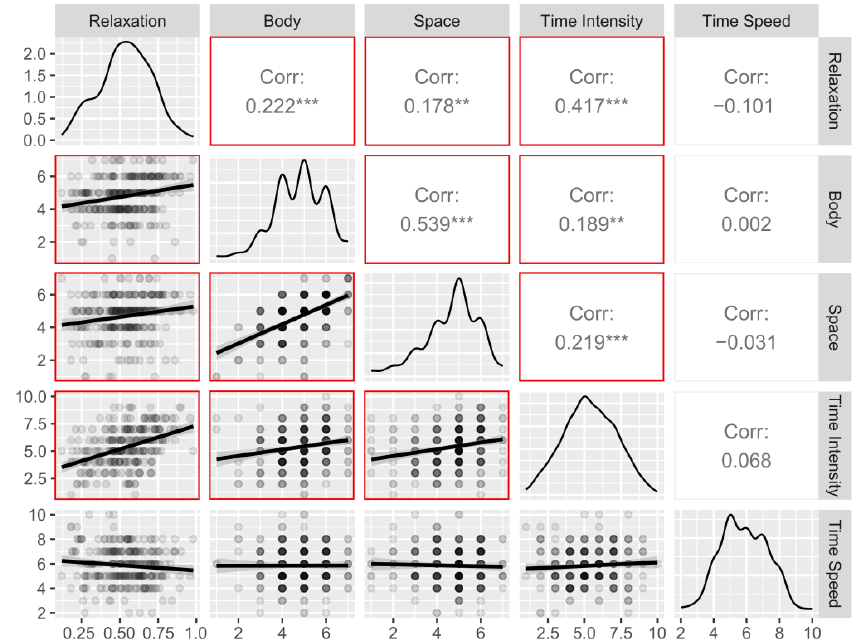
Figure 6. Relationship between pre-training indices: scatterplots, distributions, and Pearson ’ s correlations. Significant correlations are framed by the red square. Body = Body Awareness, Space = Space Awareness. *** = p < 0.001, ** = p < 0.01.